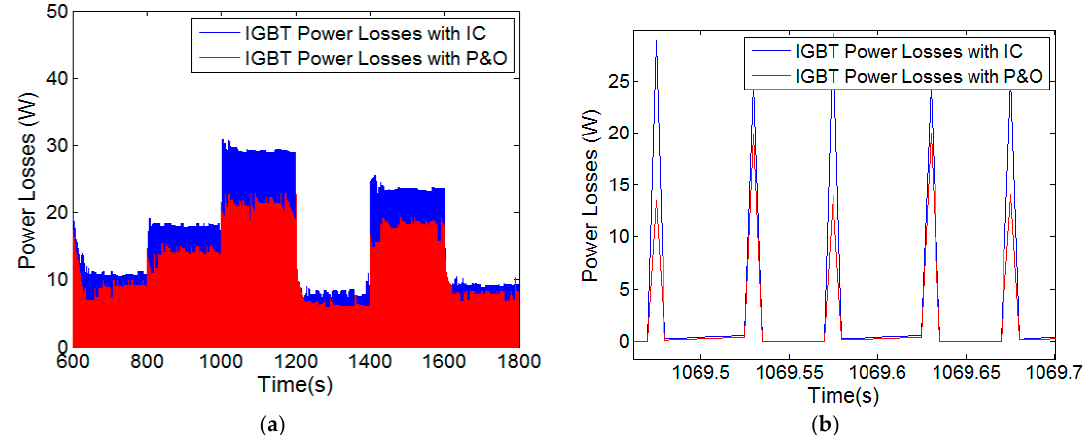
Figure 11. ( a ) Total power loss and ( b ) switching losses comparison when IC and P&O selected.